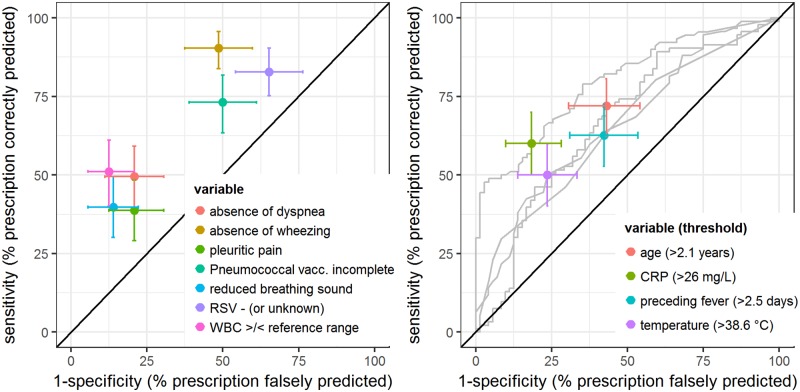
Sensitivities and specificities for associations with antibiotic prescribing.Illustration of sensitivities and specificities (dots) with 95% confidence intervals (crosses) of each single variable for antibiotic prescription. Left panel: dichotomous variables. Right panel: For continuous variables the range of sensitivities and specificities for all possible thresholds is illustrated (gray receiver operating characteristic curves), as well as the sensitivity and specificity associated with the best threshold estimates. Best threshold estimates (95%CI) were: CRP: 26 (12–55) mg/L, age: 2.1 (1.1–4.8) years, temperature: 38.6 (37.3–38.9) °C, preceding fever: 2.5 (1.5–5.5) days. CRP: C-reactive protein. RSV: Respiratory syncytial virus. WBC: White blood cell count.